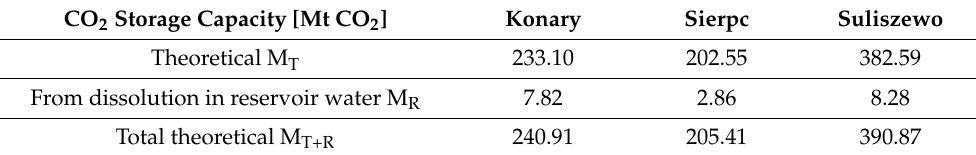
Table 5. Summary of the theoretical capacity, capacity from dissolution in reservoir water, and total theoretical capacity for the Konary, Sierpc, and Suliszewo